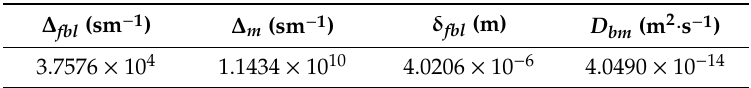
Table 1. Transport parameters of Co(II) pertraction through ultrasound prepared supported liquid membranes containing D2EHPA as